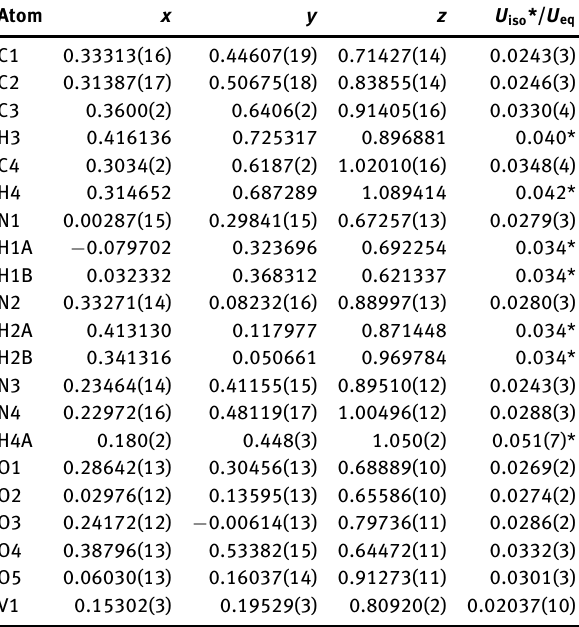
Table 2: Fractional atomic coordinates and isotropic or equivalent isotropic displacement parameters (Å 2